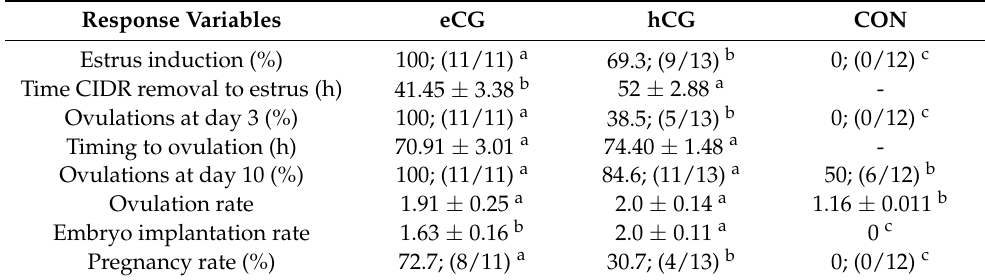
Table 1. Reproductive outcomes of Dorper ewes treated with CIDR during the seasonal anestrous and, at the time of CIDR removal, receiving either 300 IU of eCG or hCG (groups eCG and hCG) or no hormones (group